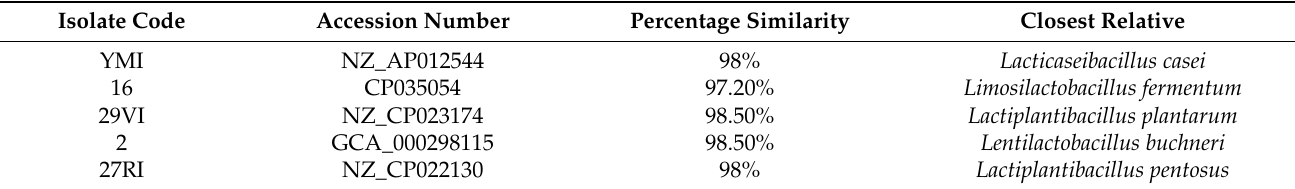
Table 2. Molecular identification of lactic acid bacteria isolates.